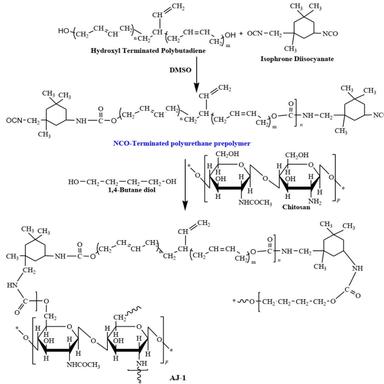
(a) Schematic of AJ-1 preparation; Fig. 1(b) Schematic of AJ-2−AJ-4 preparation; Fig. 1(c) Schematic of AJ-5 preparation.